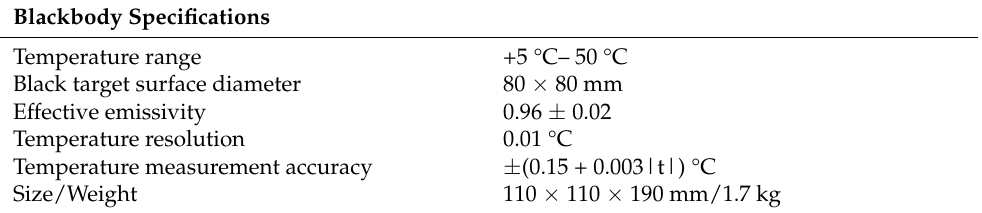
Table 3. Blackbody